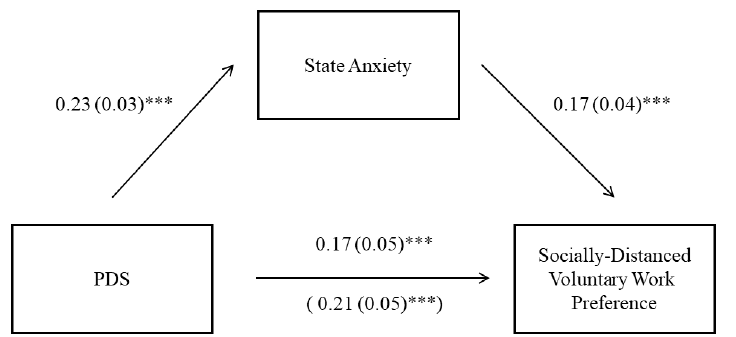
Figure 4. Mediation effect of state anxiety on the association between pathogen disgust sensitivity (PDS) and socially distanced voluntary work preference. Note. Significance of non-standardized regression coefficients (and standard error) is indicated. *** p < 0.001.